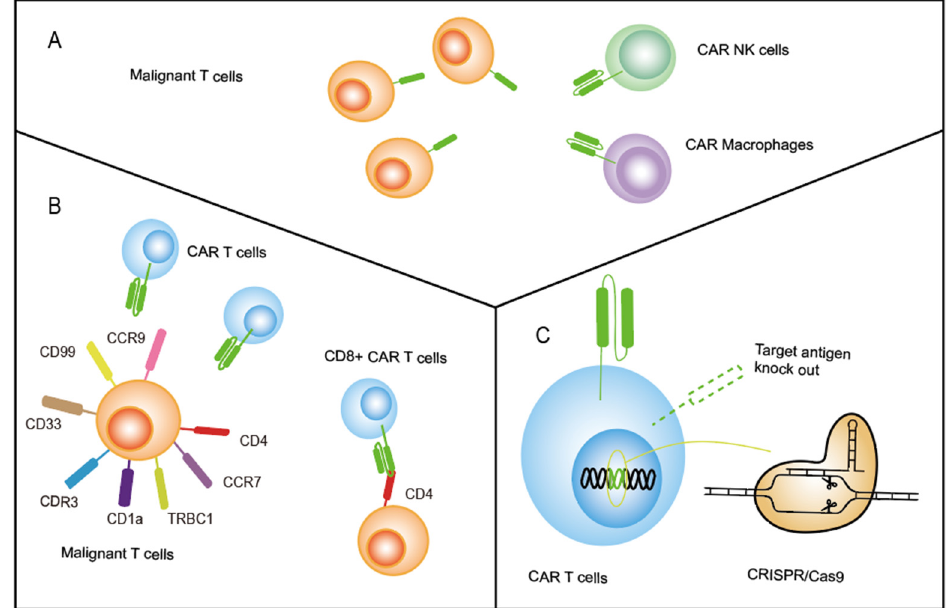
Figure 3. Promising strategies for CAR T-cell fratricide. ( A ) Other effector cells, such as NK cells and macrophages, replace T cells. ( B ) Identified specific antigens, with no expression in CAR T cells. ( C ) CRISPR/Cas9 knocks out the target antigen on CAR T